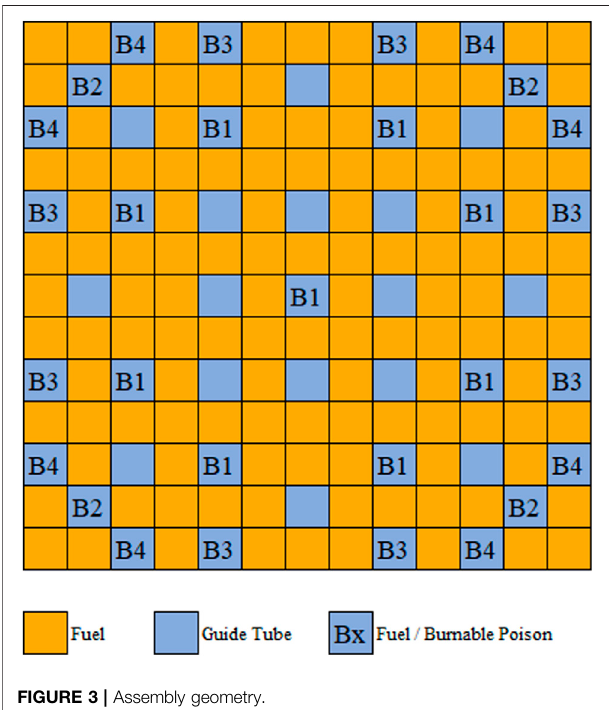
FIGURE 3 | Assembly geometry.